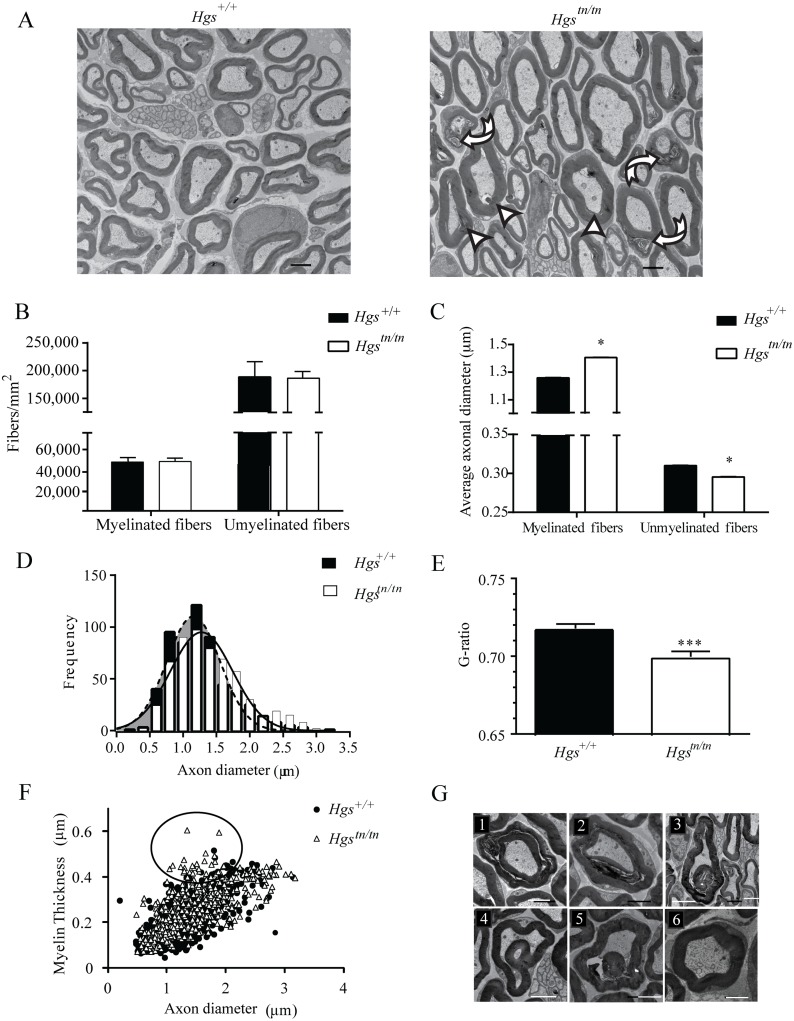
Examination of sciatic nerves from 4-week-old Hgs
+/+ and Hgs
tn/tn mice.(A) Electron micrograph of sciatic nerves from 4-week-old Hgs
tn/tn and Hgs
+/+ mice. Scale bar, 2 μm. Arrowheads indicate hypermyelinated fibers, curved arrows indicated disorganized myelin and arrows indicate demyelination. (B) Quantitation of axon density in myelinated and unmyelinated nerves. (C) Quantitation of average myelinated and unmyelinated axon diameters. (D) Histogram of frequency of axon diameters demonstrating an increase in large diameter myelinated axons in the sciatic nerves of Hgs
tn/tn mice relative to Hgs
+/+ controls. Shaded region represents axonal size distribution from Hgs
+/+ mice. An unpaired t-test with a Welch’s correction demonstrated a significant difference in the distribution of axonal size frequency between Hgs
+/+ and Hgs
tn/tn mice. (E) Quantitation of the ratio of axon diameter to total fiber thickness (G-ratio). Symbols represent unpaired t-tests. (F) Relationship between myelin thickness and axon diameter in Hgs
+/+ and Hgs
tn/tn sciatic nerves. Circled region depicts 1.0–2.0 μm diameter axons that are affected in the Hgs
tn/tn sciatic nerves. (G) Representative micrographs of myelin pathology in Hgs
tn/tn nerves demonstrating (1–2) Tomaculous fibers, (3–5) myelin infoldings compared to (6) Hgs
+/+controls. n = 3 mice per genotype. Scale bar, 5 μm. Data are shown as mean ± SE. *p<0.05 and ***p<0.001.